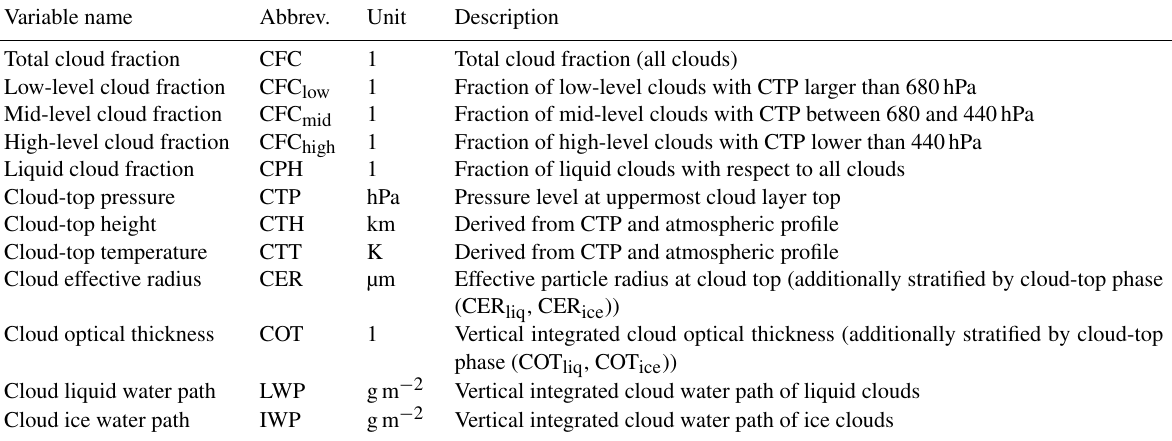
Table 2. SIMFERA output of monthly mean cloud properties. Bold font marks properties used for comparisons to observations in this study. The separation of low, mid-level and high clouds at 680 and 440hPa for CFC low , CFC mid and CFC high follows (Rossow and Schiffer,